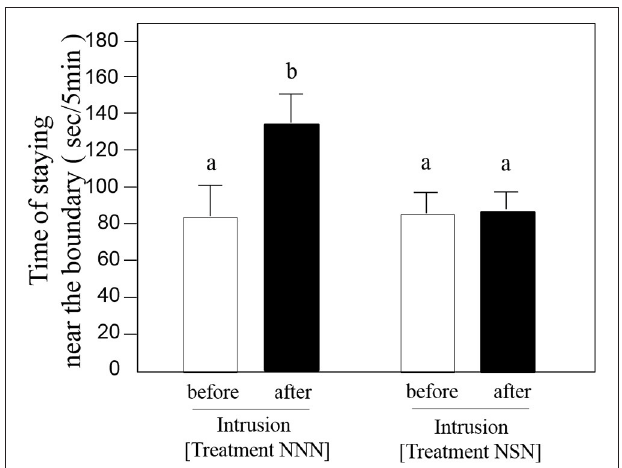
FIGURE 3 | Average duration ( ± SE, n = 8) of time spent at the boundary of the neighbor’s territory by the focal fish before (open bar) and after (solid bar) the 5-min intrusion of the neighbor [Treatment NNN] or a stranger [Treatment NSN]. The different letters above the bars denote differences at P =